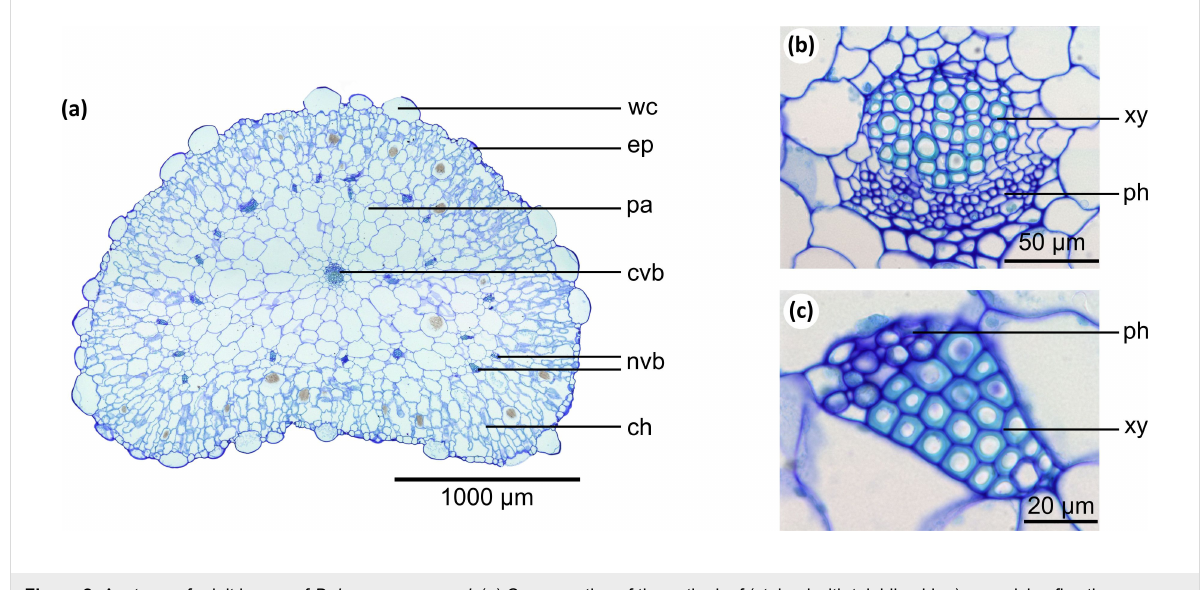
Figure 2: Anatomy of adult leaves of Delosperma cooperi . (a) Cross-section of the entire leaf (stained with toluidine blue) comprising five tissue layers: epidermis (ep) with window cells (wc), chlorenchyma (ch), net of peripheral vascular bundles (nvb), parenchyma (pa) and central vascular bundle (cvb). (b, c) Cross-sections of vascular tissues with xylem (xy) and phloem (ph), (b) central vascular bundle, (c) peripheral vascular bundle with wide-band tracheids showing pronounced cell wall thickenings.